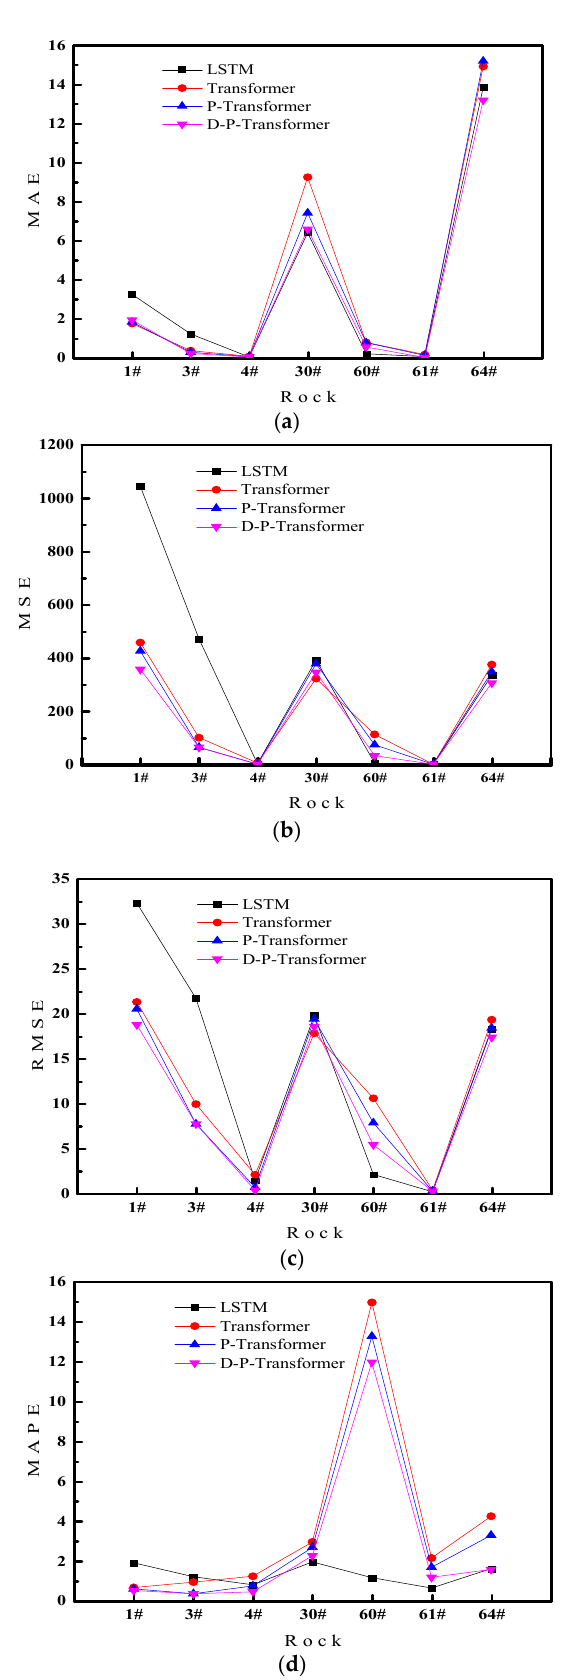
Figure 8. The metrics of various models: ( a ) MAE; ( b ) MSE; ( c ) RMSE; ( d ) MAPE. On the basis that the proposed model is superior to the original model, the prediction data of each model were observed, the maximum and minimum values were removed, and the average value was then taken as the final model evaluation metric result and com- pared with the HGSO-ANFIS algorithm [32], as reported in Table 4. The values of all per- formance metrics of the proposed D-P-Transformer rockburst prediction algorithm were better than those of the other algorithms. Moreover, in terms of the MAE, MSE, RMSE, and MAPE values, the performance of the P-Transformer algorithm was improved by 15.29%, 21.82%, 9.56%, and 21.88%, respectively, as compared with the Transformer model. In terms of the MAE, MSE, RMSE, and MAPE values, the performance of the D-P- Transformer algorithm was improved by 24.45%, 46.56%, 17.32%, and 48.11%, respec- tively, as compared with the Transformer model. In summary, in terms of the MAE, MSE, RMSE, and MAPE metrics, the proposed D-P-Transformer algorithm is the most suitable for rockburst prediction, with a smaller error and better results than the other four com- pared algorithms. Table 4. The performance comparison of various models. Methods/Metrics